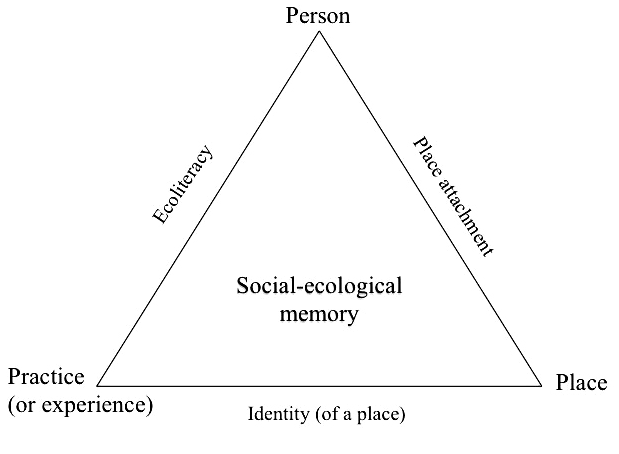
Fig. 1 . A conceptual framework for social-ecological memory as a person-practice-place complex with ecoliteracy, place attachment, and identity as emergent outcomes of their complex